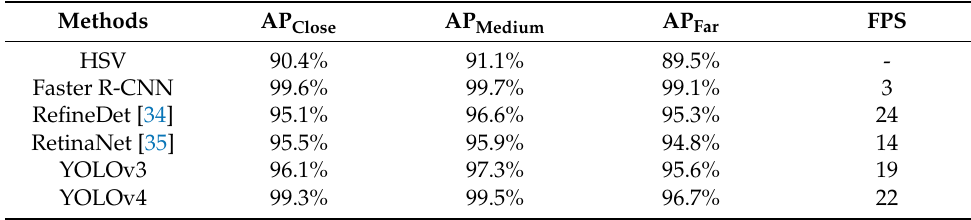
Table 1. Object detector performance